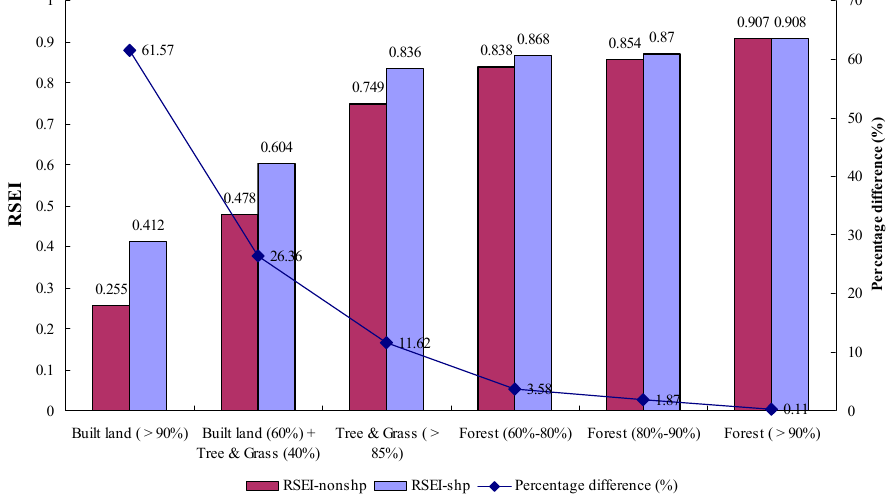
Figure 10. Comparison between RSEIs computed with and without sharpened LST in the samples with different proportions of built land and plant cover.